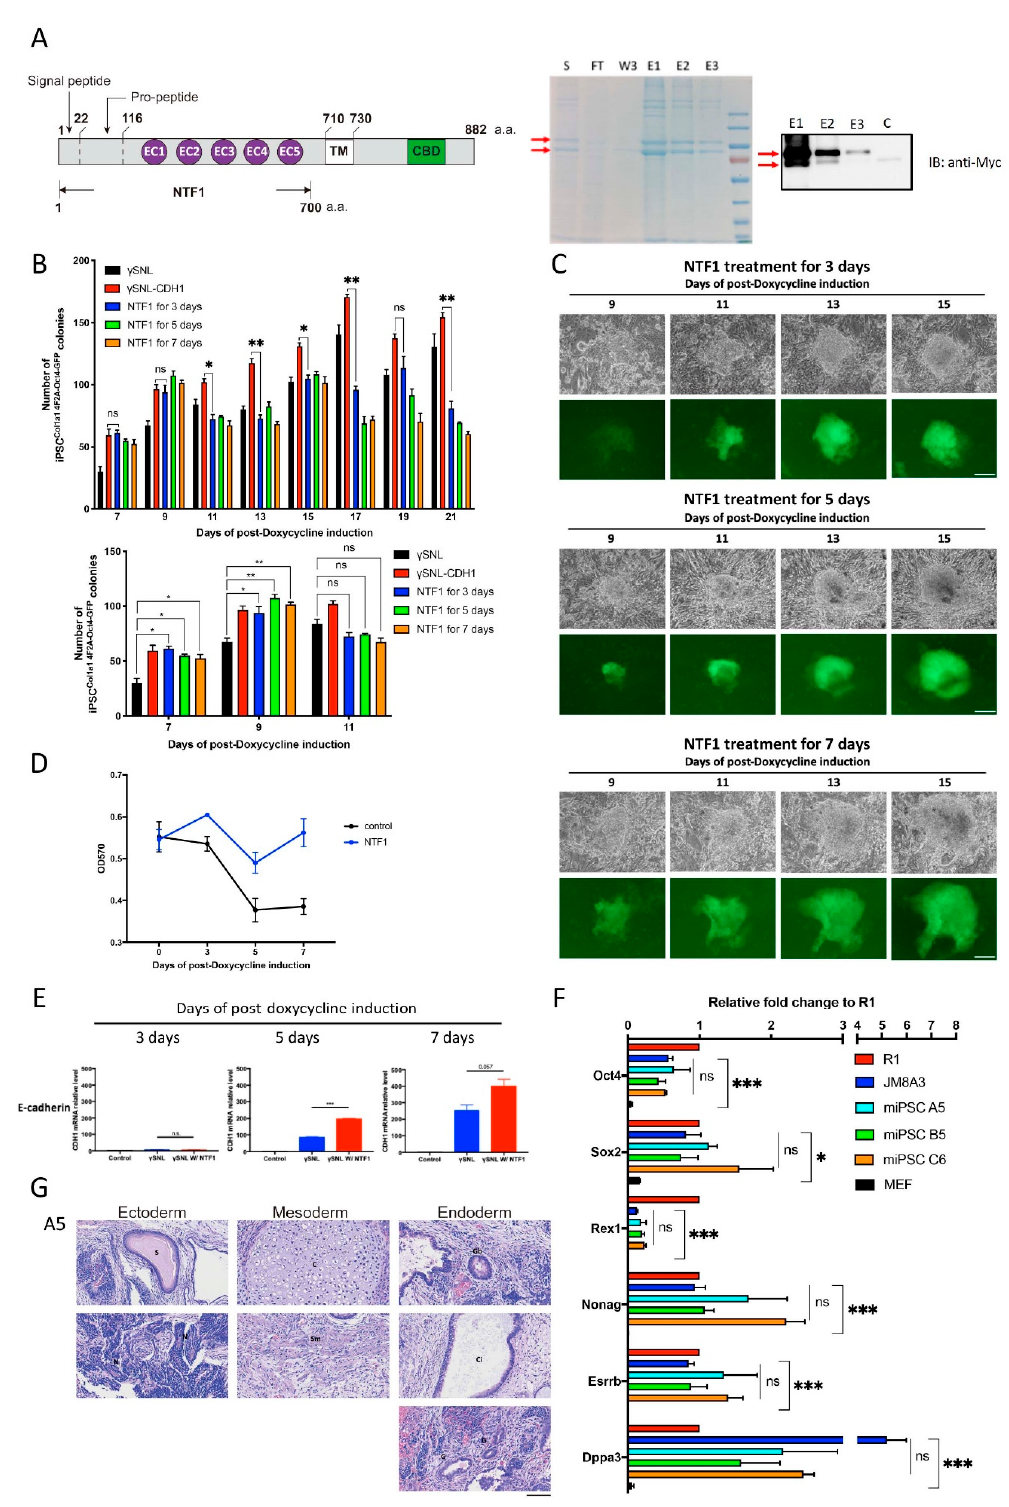
Figure 2. The effect of NTF1 recapitulates the SNL::CHD1-myc feeder adoption at the early stage of reprogramming. ( A ) Schematic display of the structure of NTF1 protein and purification of the recombinant NTF1 protein. The culture medium